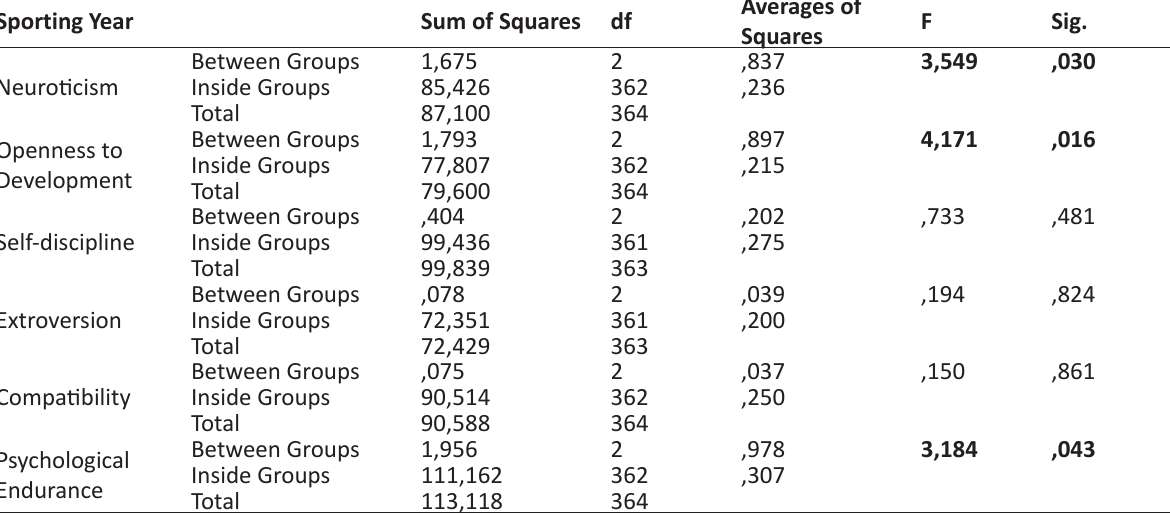
Table 4. F-test results regarding the difference between psychological endurance and personality characteristics according to the year of not doing sports